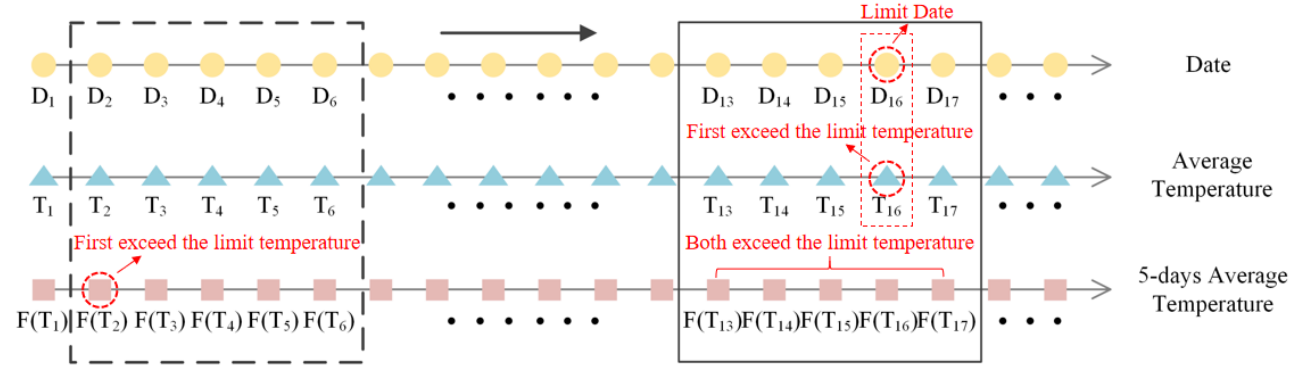
Figure 4. Principle diagram of 5-day moving average method.